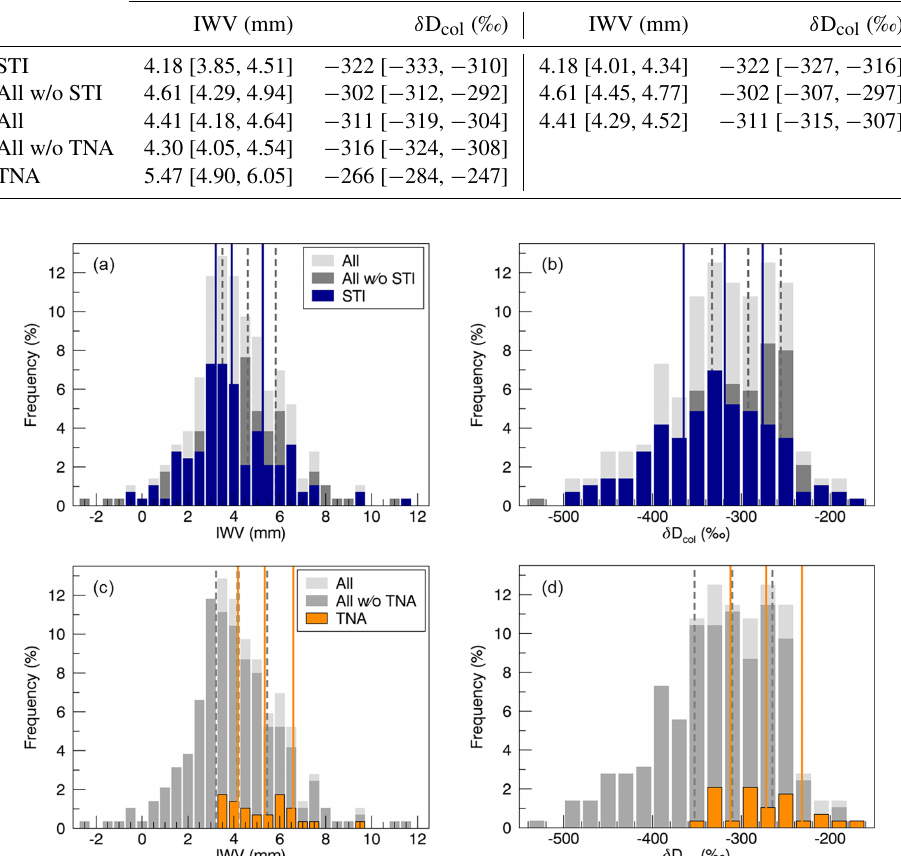
Figure 9. Distributions of deseasonalized daily mean IWV and column-based δ D for days identified as (a, b) stratospheric-intrusion events and as (c, d) dust transport events from northern Africa. For comparison, distributions for all FTIR measurement days in 2013–2015 are shown as well as distributions excluding the respective transport events. Vertical lines indicate median and 25th–75th-percentile range for each distribution (STI/all without STI and TNA/all without